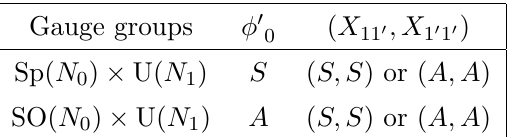
Table 12. The orientifold involution (cid:10) of the non-chiral orbifold C 3 = Z 0 3 . \A" stands for \Anti- symmetric representation", while \S" for \Symmetric